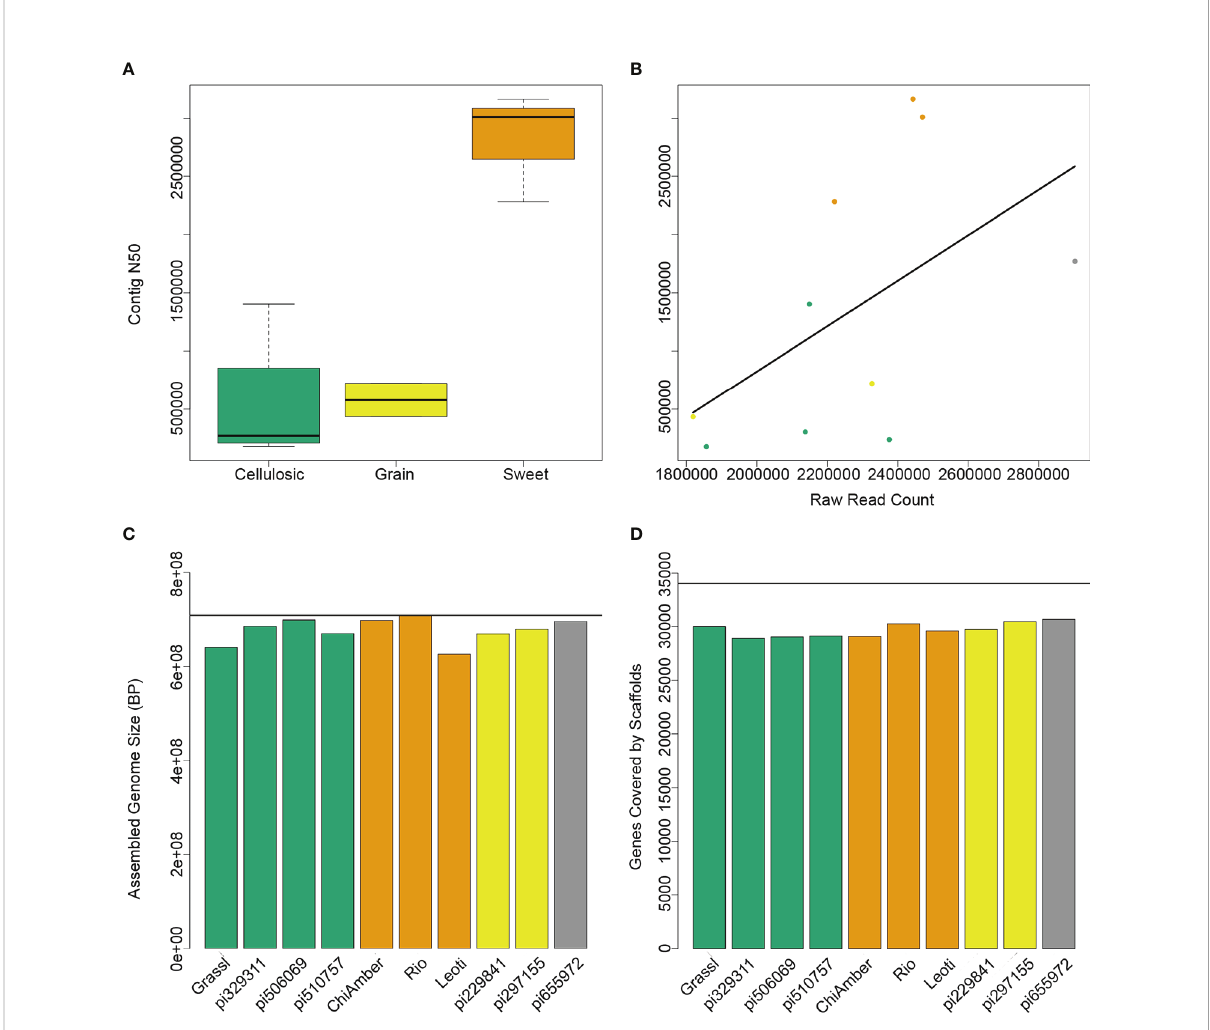
FIGURE 1 Assembly metrics for 10 sorghum genotypes. (A) Contig N50 levels for different ideotypes show higher contiguity for sweet genotypes. (B) Raw read counts prior to assembly are highly correlated with contig N50, and sweet genotypes (orange) have higher read counts than cellulosic (green) or grain (yellow) genotypes. (C) Assembled genome size after scaffolding and fi ltering for each genotype shows that despite differences in mean contig size, the fi nal assemblies for both sweet and non-sweet types are very close to the expected reference genome size (horizontal black line). (D) The number of BTx623 genes contained within the fi nal scaffolds is very similar across all genotypes regardless of